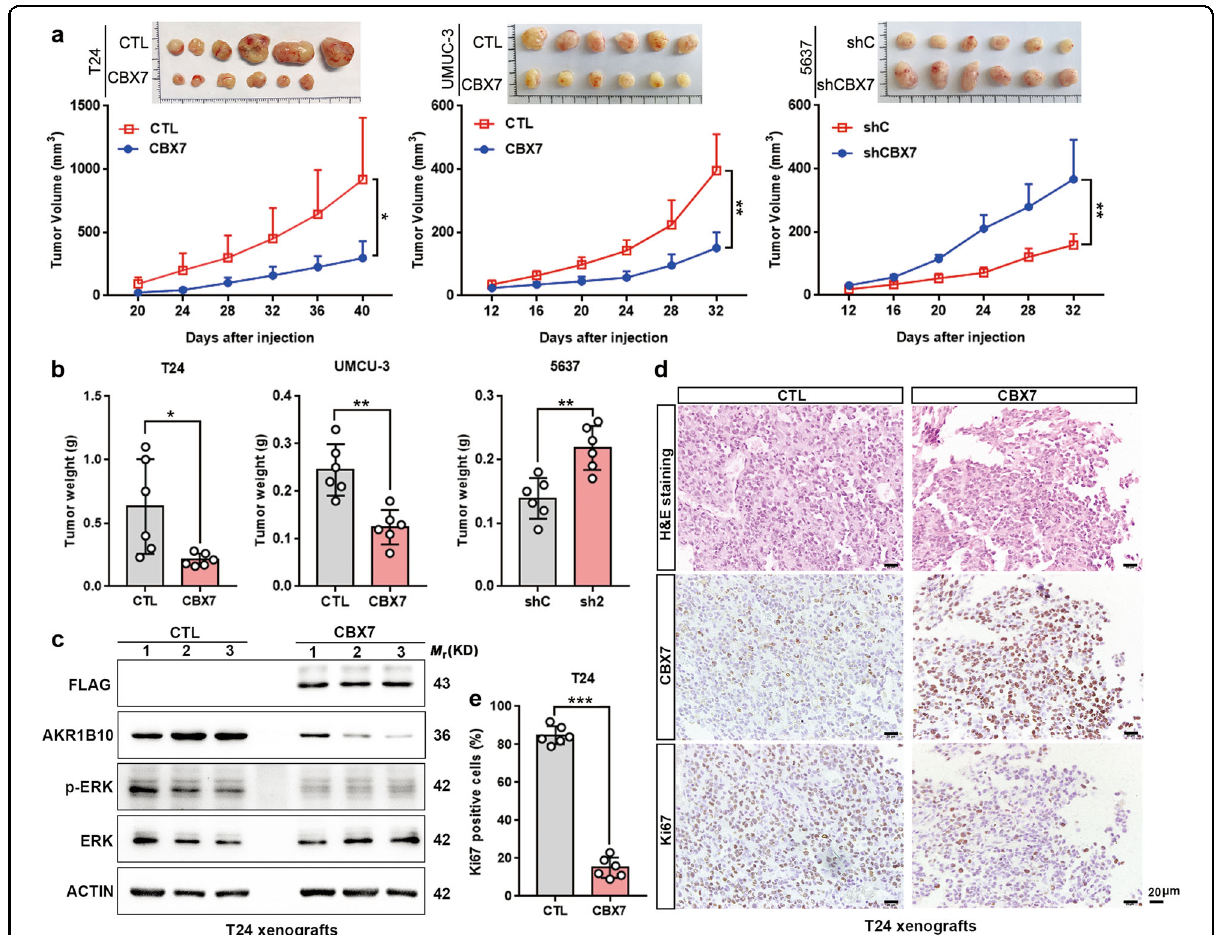
Fig. 7 CBX7 inhibits tumorigenicity in vivo. a , b Tumor growth curves and tumor weights of xenografts were represented. c CBX7, AKR1B10, p-ERK, and ERK expression in the xenografts of T24-CBX7 were determined by western blotting. d , e H&E staining was used to monitor UBC cells morphology, IHC staining for CBX7 substantiated ectopic CBX7 expression, and Ki-67 staining revealed a signi fi cant reduction of cell proliferation in T24 xenografts expressing CBX7 by counting the proportion of Ki-67-positive cells. Scale bar, 20 μ m. Data are presented as means ± SD of six mice from each group. * p < 0.05, ** p < 0.01, *** p <